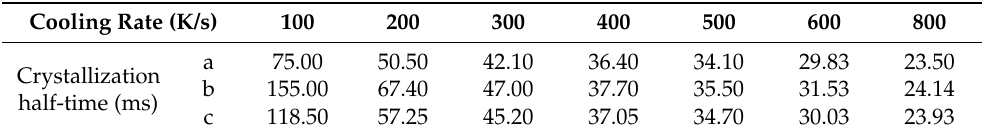
Table 4. Crystallization half time for different cooling rates of (a) PEG in method 1, (b) PEG-PLLA in method 1 and (c) PEG-PLLA in method 2.